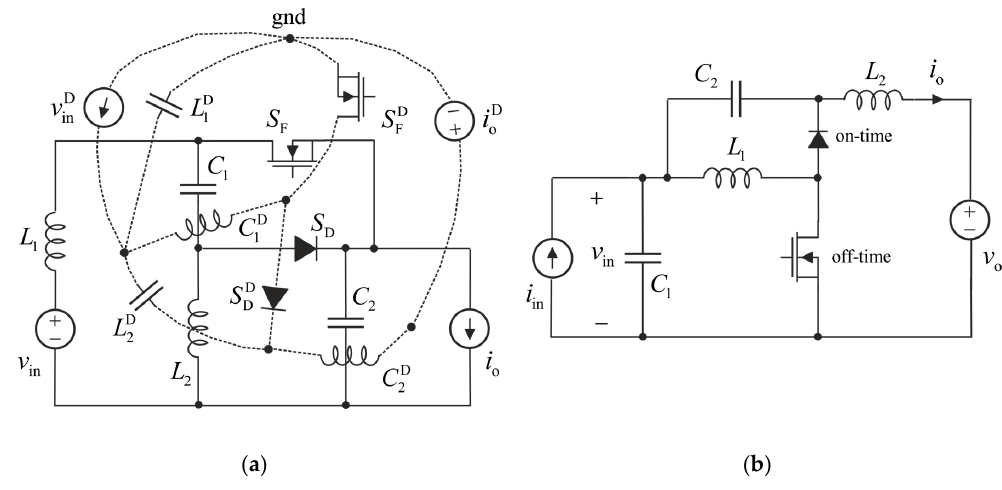
Figure 11. Application of duality transformation to ( a ) voltage-fed superbuck converter (solid line) to implement; and ( b ) the corresponding current-fed superbuck converter.